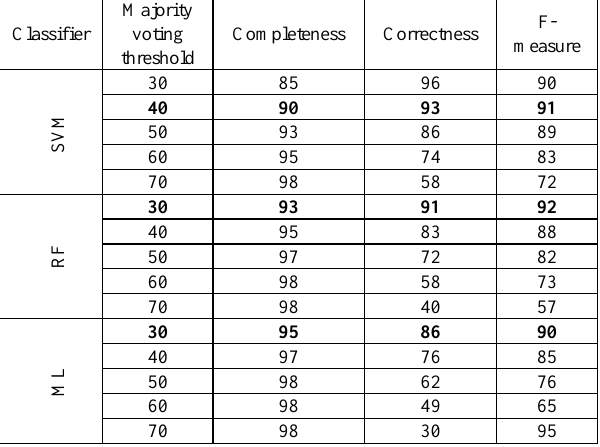
Table 1. The result of object-based shadow detection